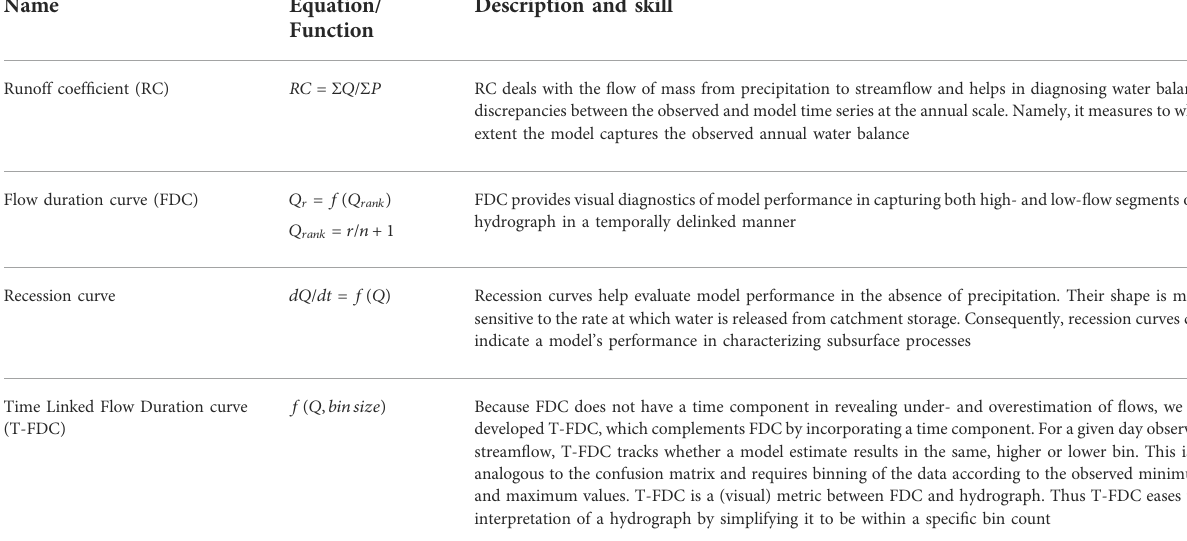
TABLE 2 List and description of hydrological signature-based model diagnostic metrics in HydroBench. Here, Q denotes stream fl ow, an example of the dependent variable, P denotes precipitation, an example of an input fl ux variable, and r denotes rank based on a decreasing sorting of a time